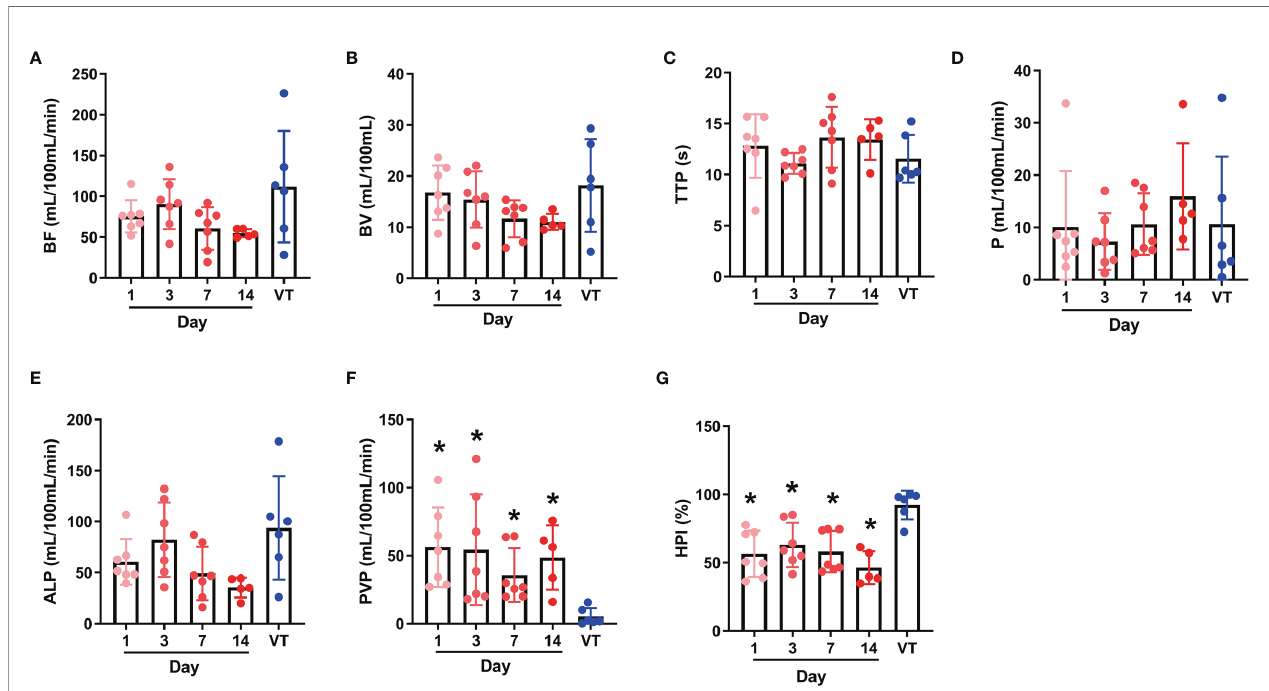
FIGURE 2 | Individual values of postoperative perfusion parameters of benign periablational enhancement (BPE) and viable tumors (A – G) represent the individual values of CT perfusion parameters BF, BV, TTP, P, ALP, PVP, and HPI respectively. BPE, Benign periablational enhancement; BF, blood fl ow; BV, blood volume; TTP, time to peak; P, permeability; ALP, arterial liver perfusion; PVP, portal vein perfusion; HPI, hepatic perfusion index. *P < 0.05, compare with VT (viable